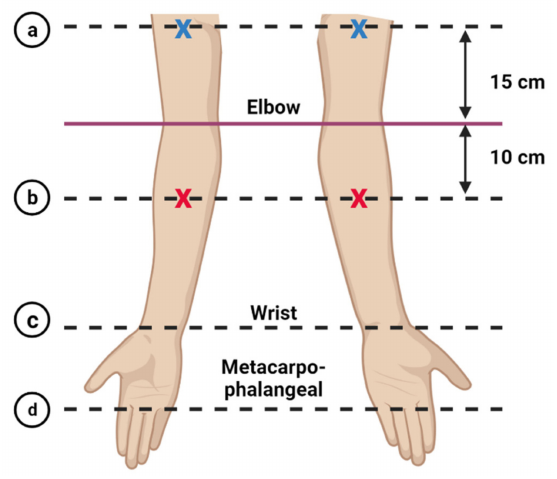
Figure 2. Points of the arm circumference measurement performed on the study participants. The four points are marked as ( a ) 15 cm from the antecubital fossa (anterior surface of the elbow) to the lateral epicondyle of humerus, ( b ) 10 cm distal to antecubital fossa of the arm, ( c ) the wrist and ( d ) the metacarpal-phalangeal joint. The ultrasound examination was performed on the mid-point of anterior surface of upper arm (blue X) and forearm (red